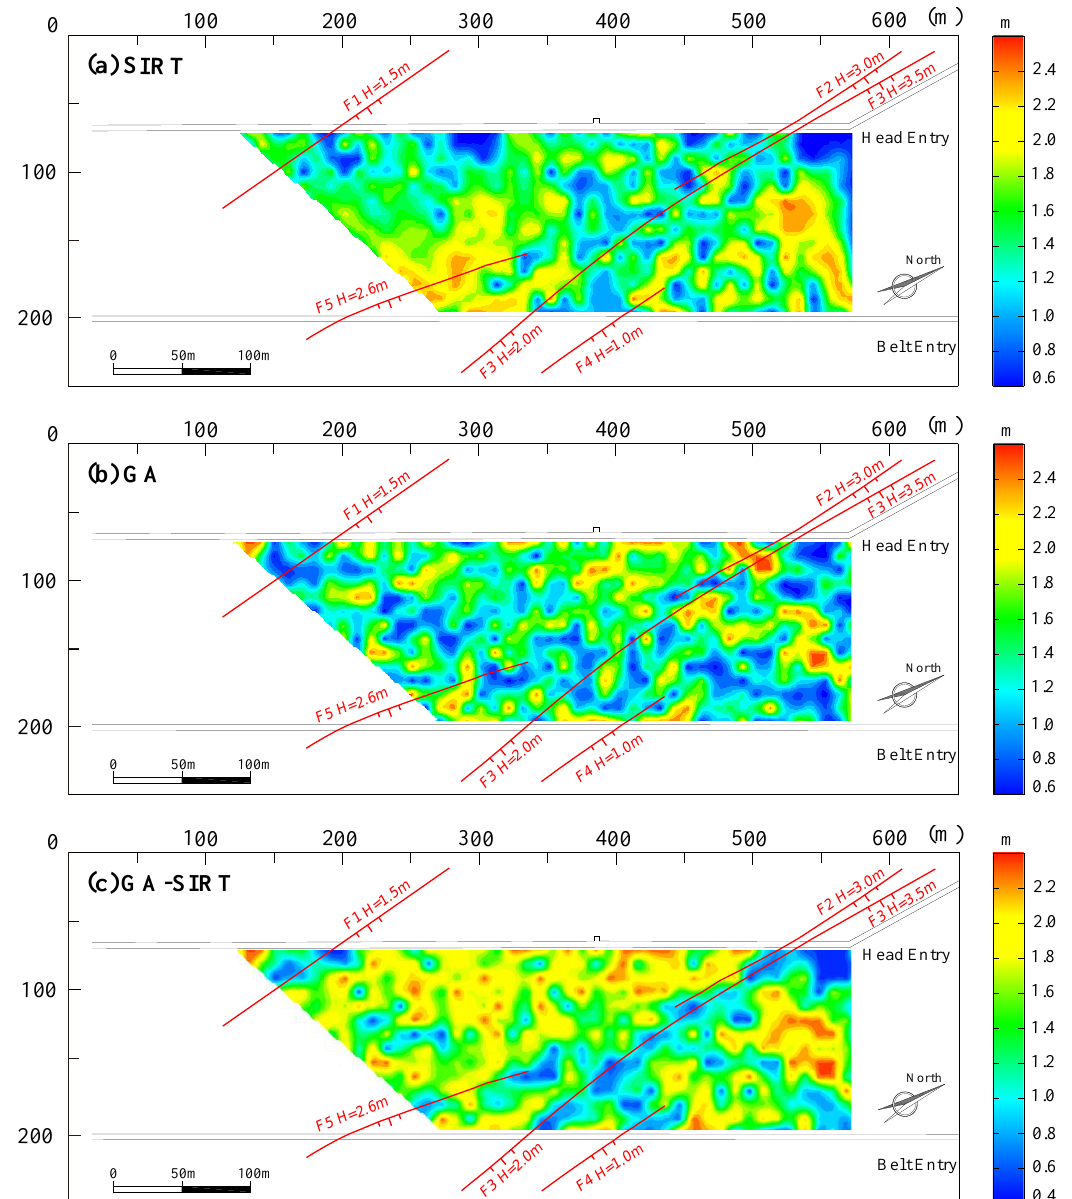
Figure 6. Distribution of coal seam thickness within survey areas. ( a ) Coal seam thickness distribution with SIRT algorithms; ( b ) coal seam thickness distribution applying GA algorithms; ( c ) coal seam thickness distribution employing GA-SIRT algorithms.